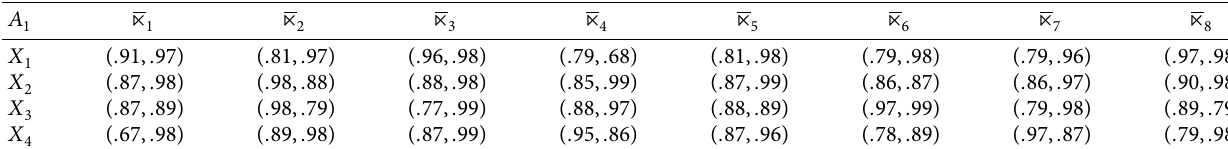
Table 6: Decision matrix for alternative ( A